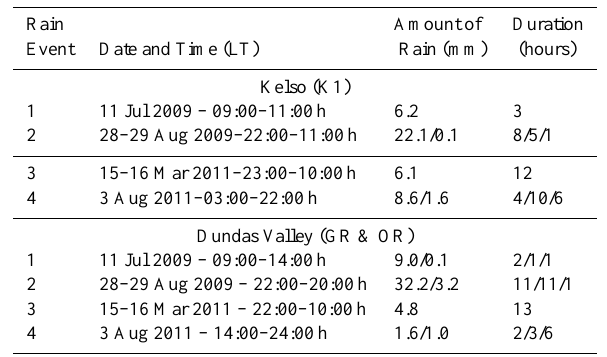
Table 4. Characteristics of analysed rain events. If a rain event is broken into two distinct rainfalls, the amount of rain in each is sep- arated, and the duration is separated as first rainfall duration, gap length, and second rainfall duration.